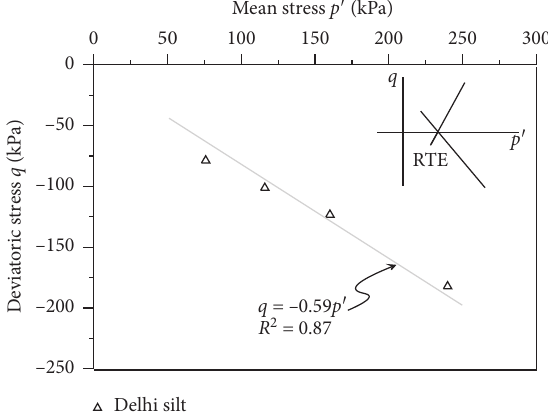
Figure 12: Strength envelope of Delhi silt in extension